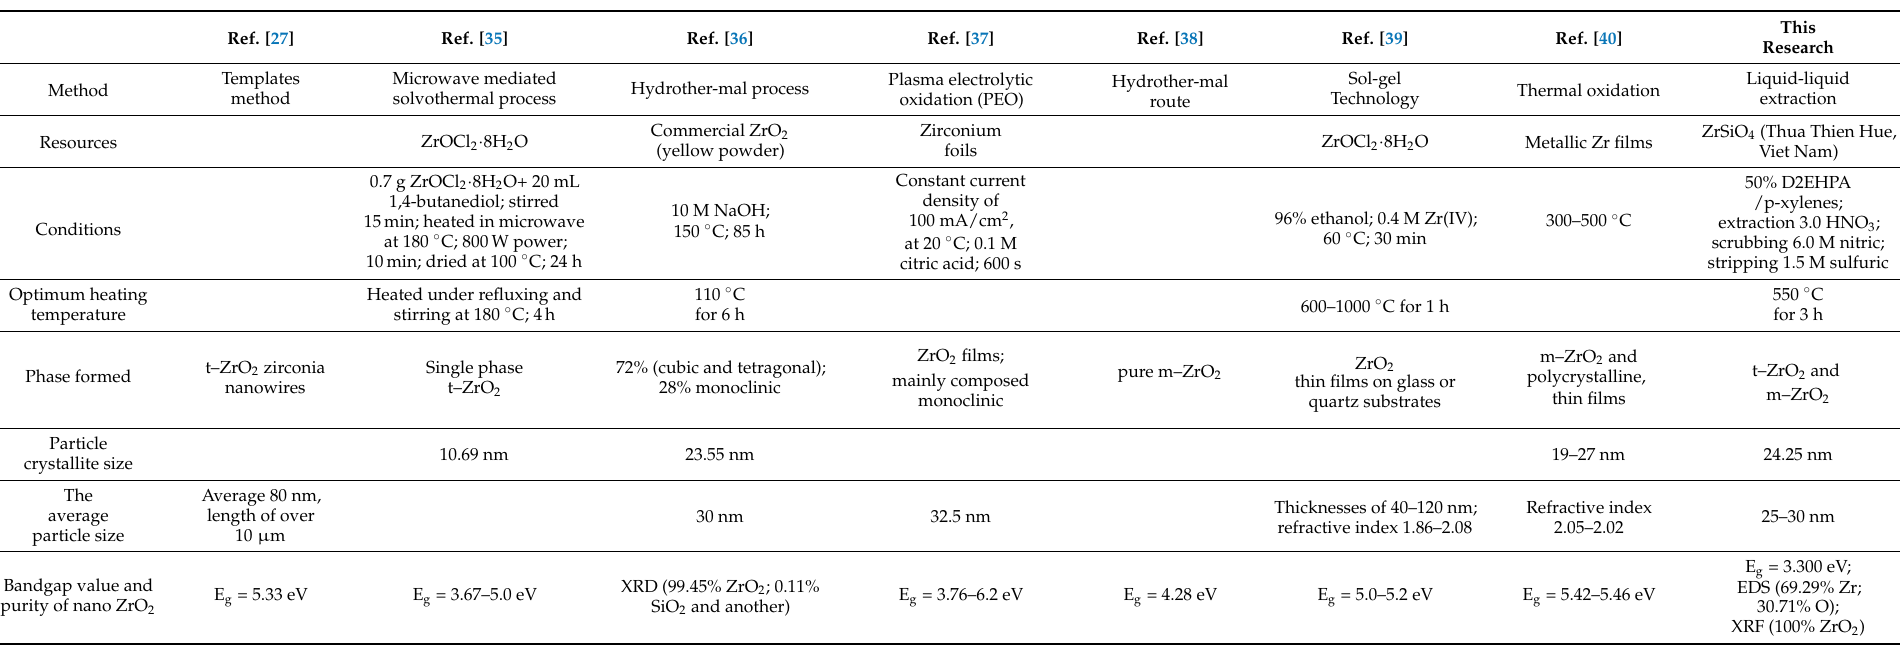
Table 2. Comparison of purification method and characterization of ZrO 2 sample in previous